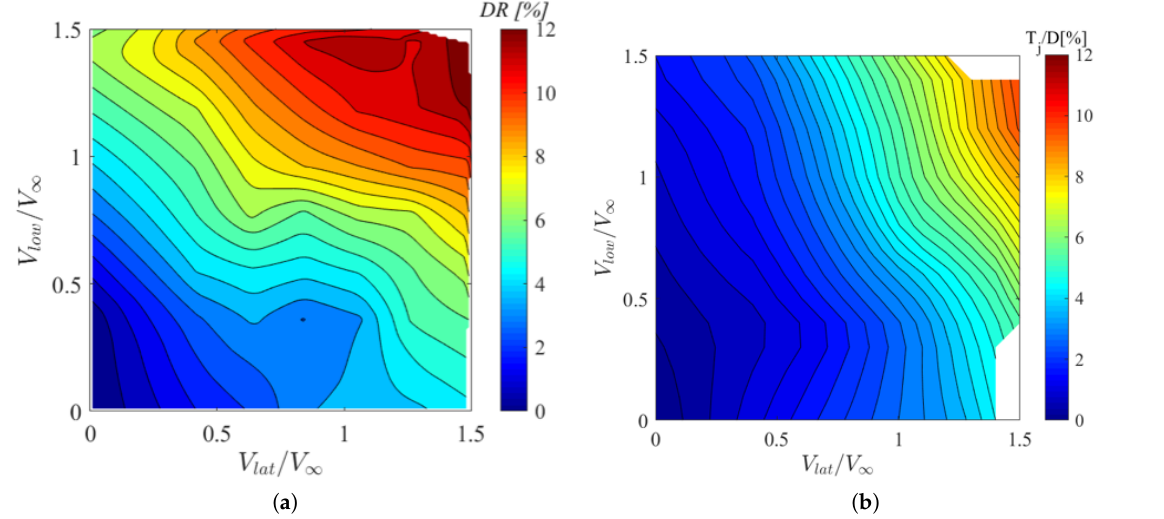
Figure 8. ( a ) Map of drag reduction for asymmetrical forcing. Lower and lateral jet effects. ( b ) Effect of